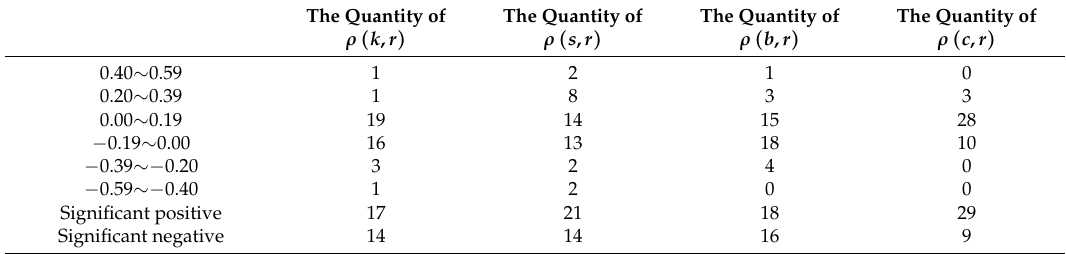
The Quantity of The Quantity of The Quantity of The Quantity of ρ ( k , r ) ρ ( s , r ) ρ ( b , r ) ρ ( c , r )